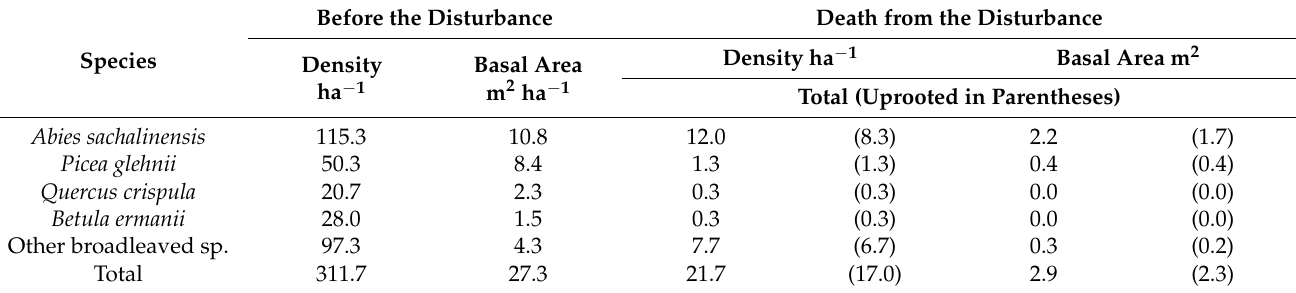
Table 1. Tree species composition and the damage caused by the strong wind in the 3-ha study stand. Before the Species